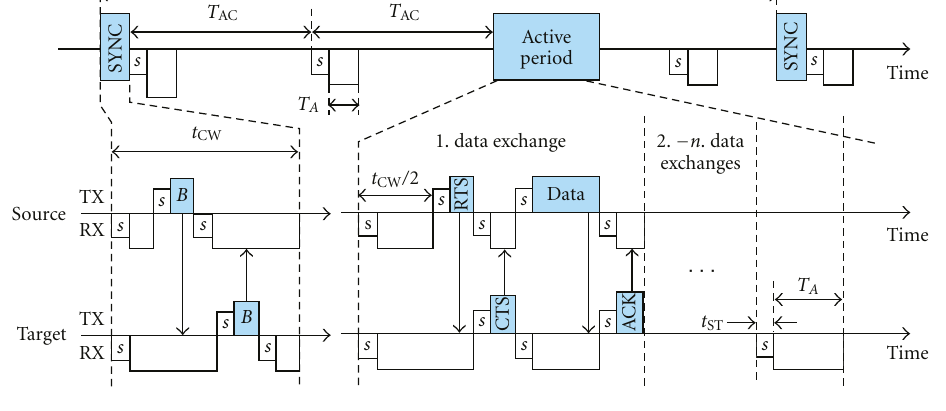
Figure 11: The activity of radio in T-MAC.